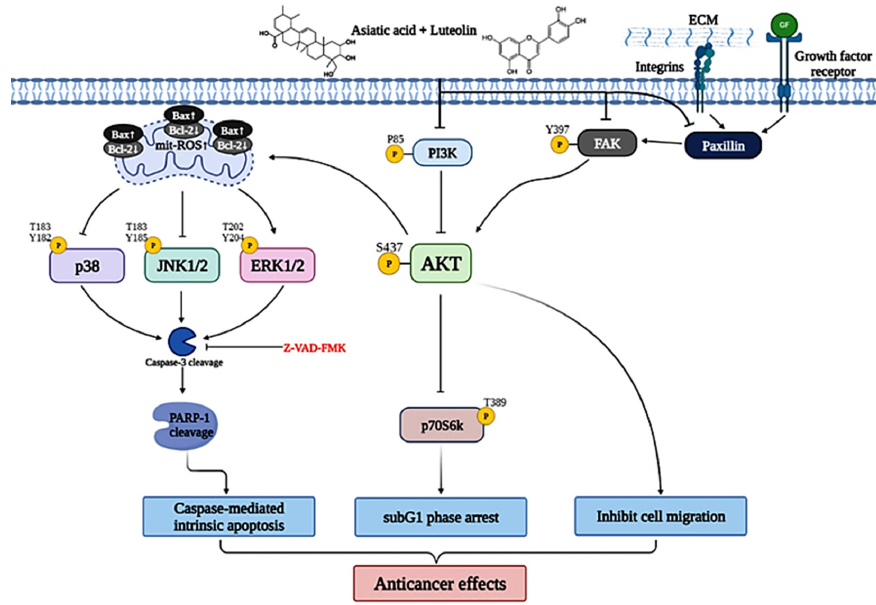
Figure 10. Schematic diagram of luteolin combined with asiatic acid’s anticancer molecular mechanism in cervical cancer. Lut combined with AsA mainly modulates FAK signaling (integrin β 1, paxillin and FAK) and PI3K/AKT signaling (PI3K, AKT and p70S6K) and causes JNK/p38 downregulation and ERK upregulation, inactivating or activating various signaling targets, such as Bcl2, Bax, mitROS, caspase-3 and RARP1; this leads to the induction of caspase-mediated intrinsic apoptosis, sub-G1 phase arrest and inhibition of cancer cell migration, which increase the anticancer effect on cervical cancer.